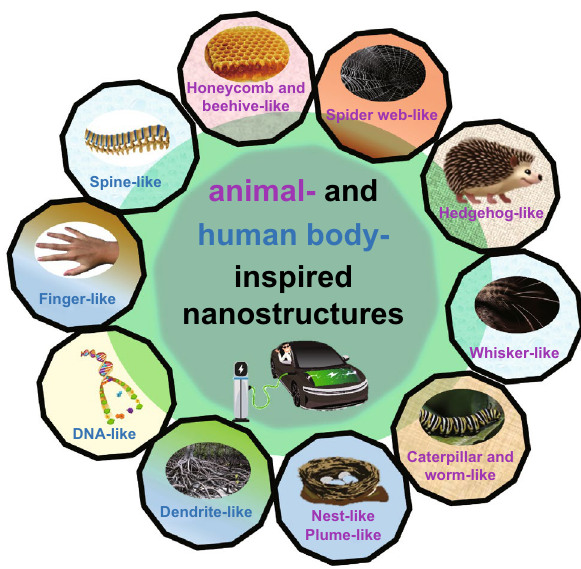
Fig. 1 Schematic illustration of animal- and human body-inspired nanostructures